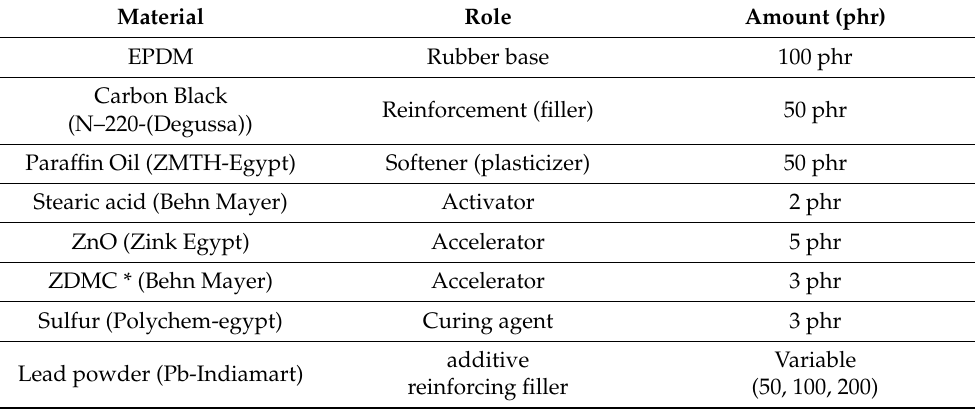
Table 1. The chemical formulations and ingredients used for sample preparation (in phr). Material Role Amount (phr) EPDM Rubber base 100 phr Carbon Black Reinforcement (filler) 50 phr (N–220-(Degussa)) Paraffin Oil (ZMTH-Egypt) Softener (plasticizer) 50 phr Stearic acid (Behn Mayer) Activator 2 phr ZnO (Zink Egypt) Accelerator 5 phr ZDMC * (Behn Mayer) Accelerator 3 phr Sulfur (Polychem-egypt) Curing agent 3 phr additive Lead powder (Pb-Indiamart) reinforcing filler